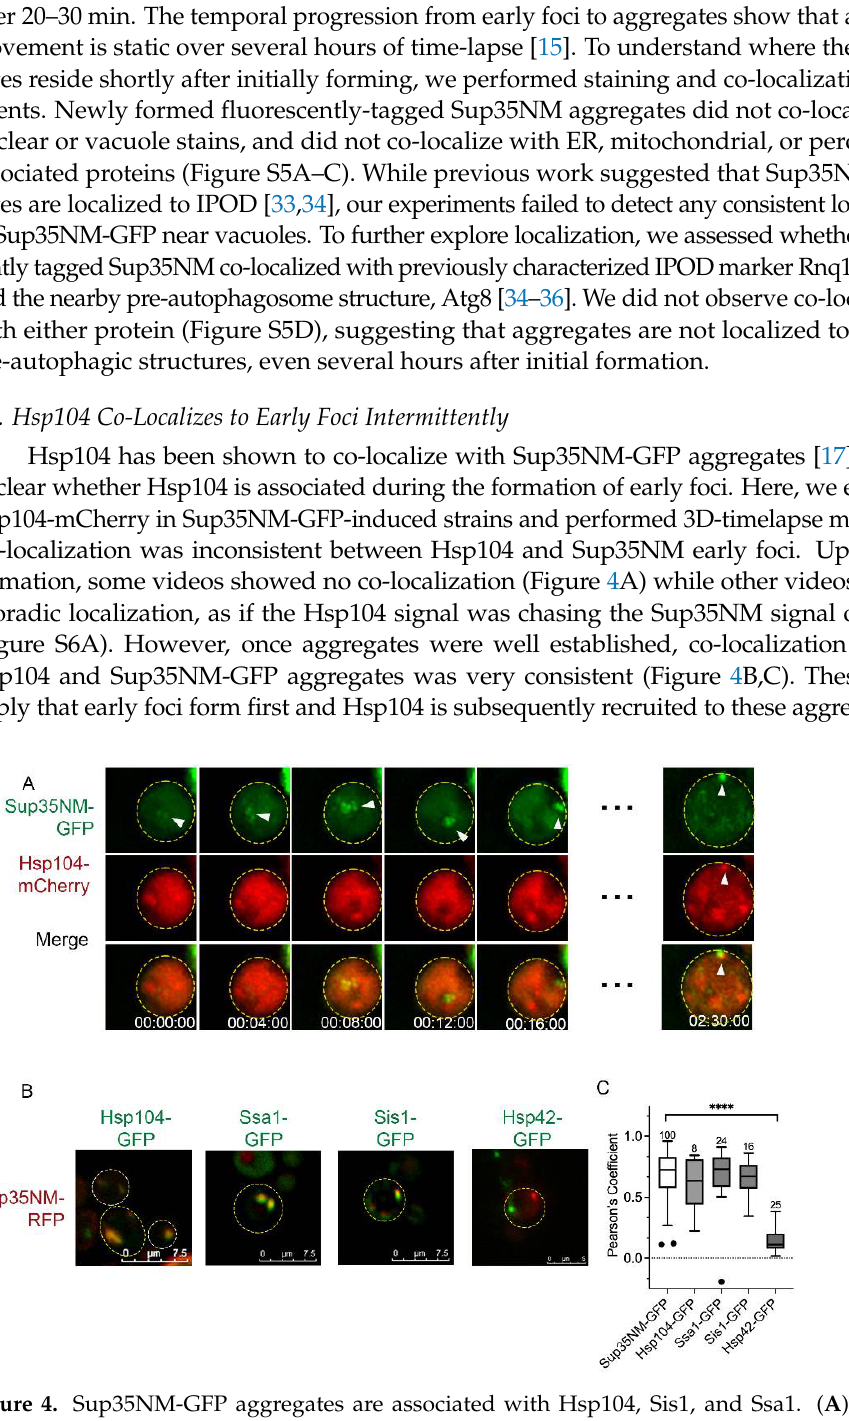
Figure 4. Sup35NM-GFP aggregates are associated with Hsp104, Sis1, and Ssa1. ( A ) 3D Time-lapse microscopy of early foci in wildtype cells expressing Hsp104-mCherry. ( B ) Co-localization of Sup35NM-RFP aggregates (shown in green) and indicated GFP proteins (red). ( C ) Pearson’s correlation coefficient was used to quantify the degree of co-localization between Sup35NM-RFP and the indicated proteins. Note that co-localization between Sup35NM-GFP and Sup35NM-RFP is used as a control. Data shown as box and whisker plots with medians and interquartile ranges, and number of cells analyzed above each box. Dots indicate outliers as identified by Tukey analysis. Only Hsp42-GFP is significantly different from controls as determined by Welch’s t -test. **** p < 0.001.